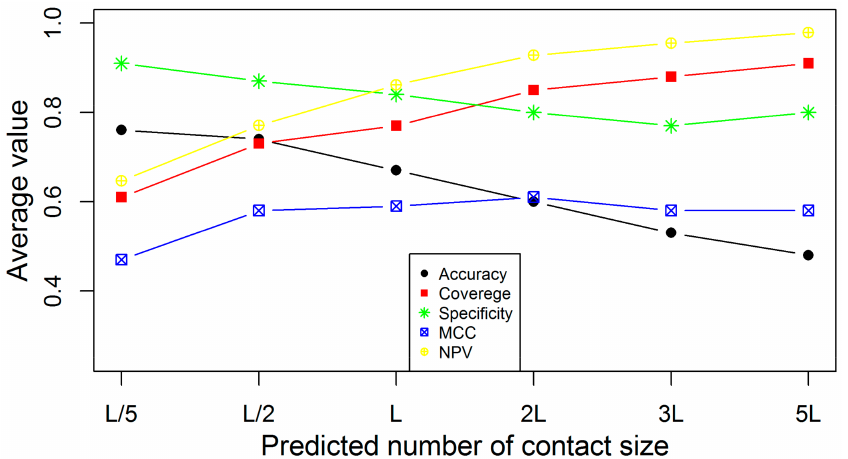
Figure 6. The average accuracy, coverage, specificity, NPV, and MCC of COMTOP at predicted contact sizes on CASP13